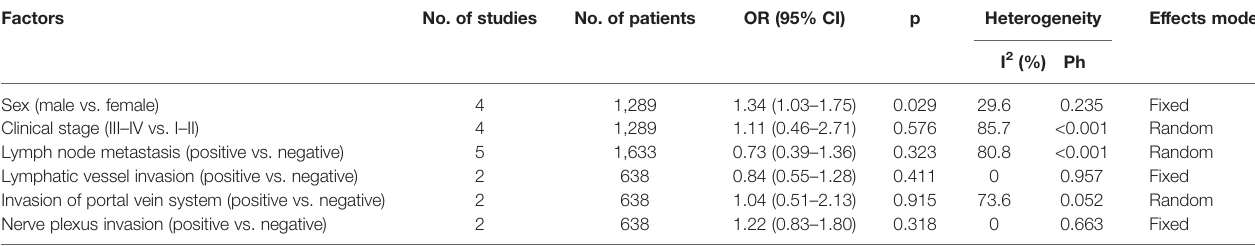
TABLE 4 | The association between COUNT score and clinicopathological features in patients with pancreatic cancer.